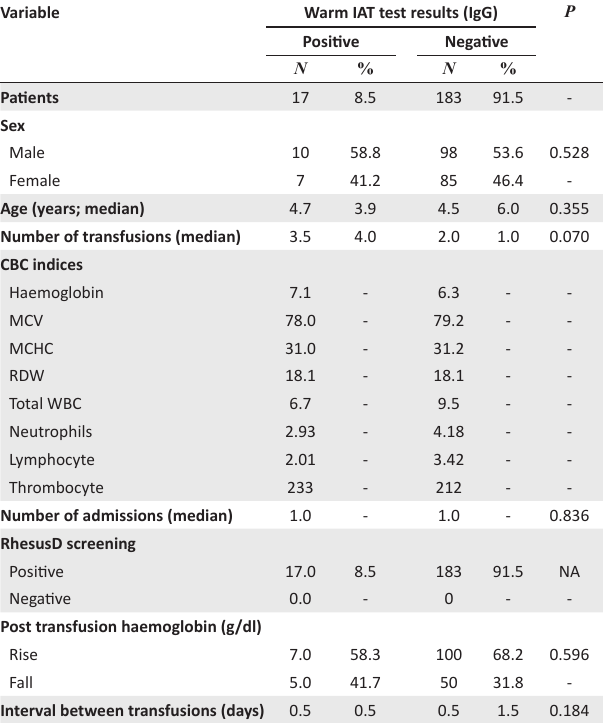
TABLE 3: Demographic characteristics of sickle cell patients having warm alloantibodies at Bugando Medical Centre, May 2017–July 2017.